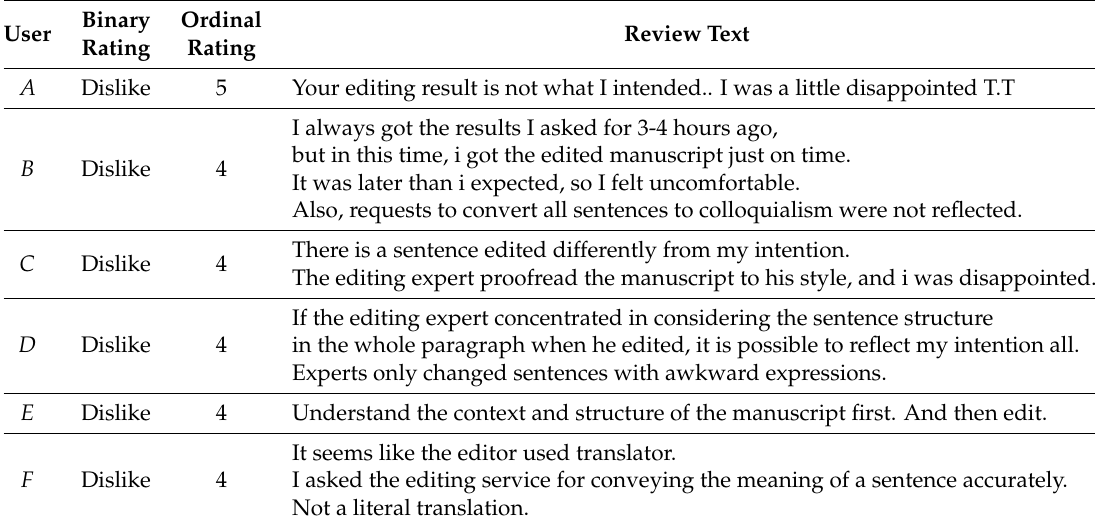
Table 1. Examples of user feedback logs composed of binary ratings, ordinal ratings, and review texts, where the category of binary ratings are dislike while the those of ordinal ratings are 4 or